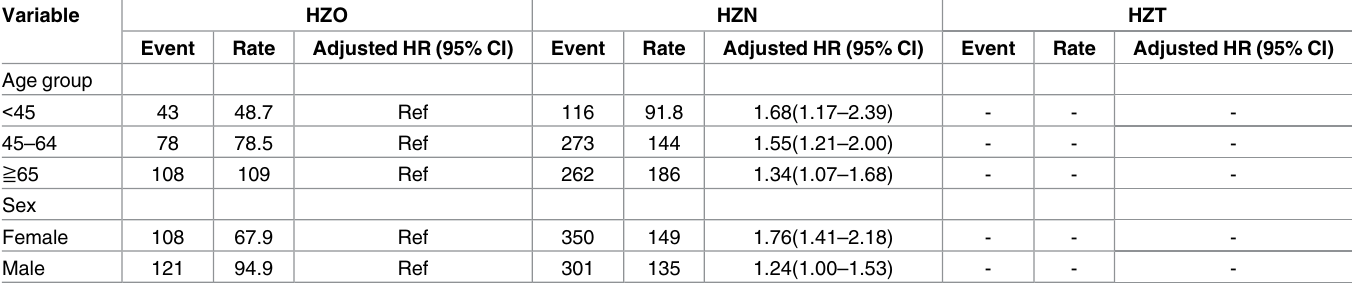
Table 7. Risk of herpes zoster complications (other visceral) in different types of herpes zoster stratified by age and sex. Adjusted HR: Adjusted for age, sex, CAD, hypertension, hyperlipidemia, DM, stroke, AF, renal disease, heart failure, cancer, chronic hepatitis, and SLE. Rate: incidencerate per 1000